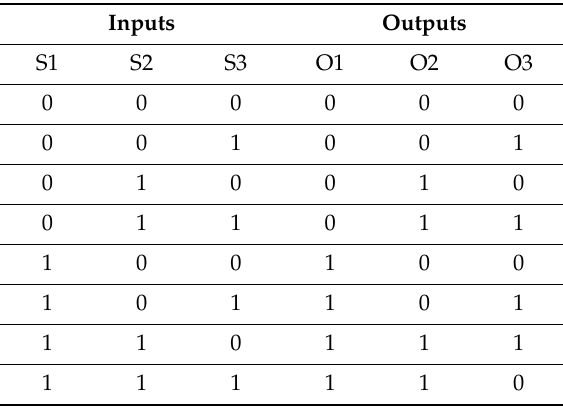
Table 1. Truth table related to three probabilistic bits. Inputs